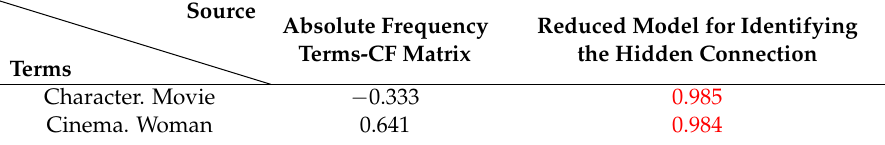
Table 6. Example of Results of the Comparison of the CC between